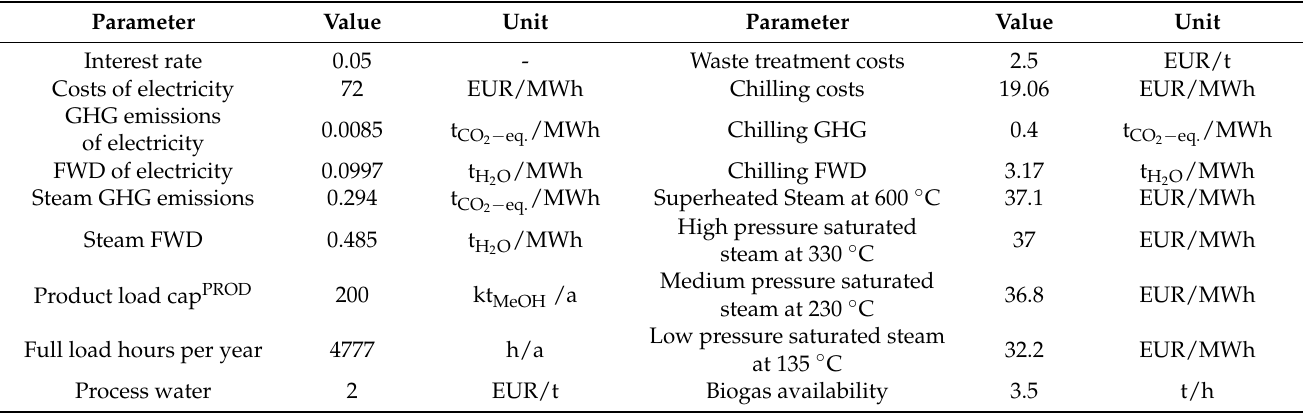
Table 6. Assumptions on key parameters (data adapted from